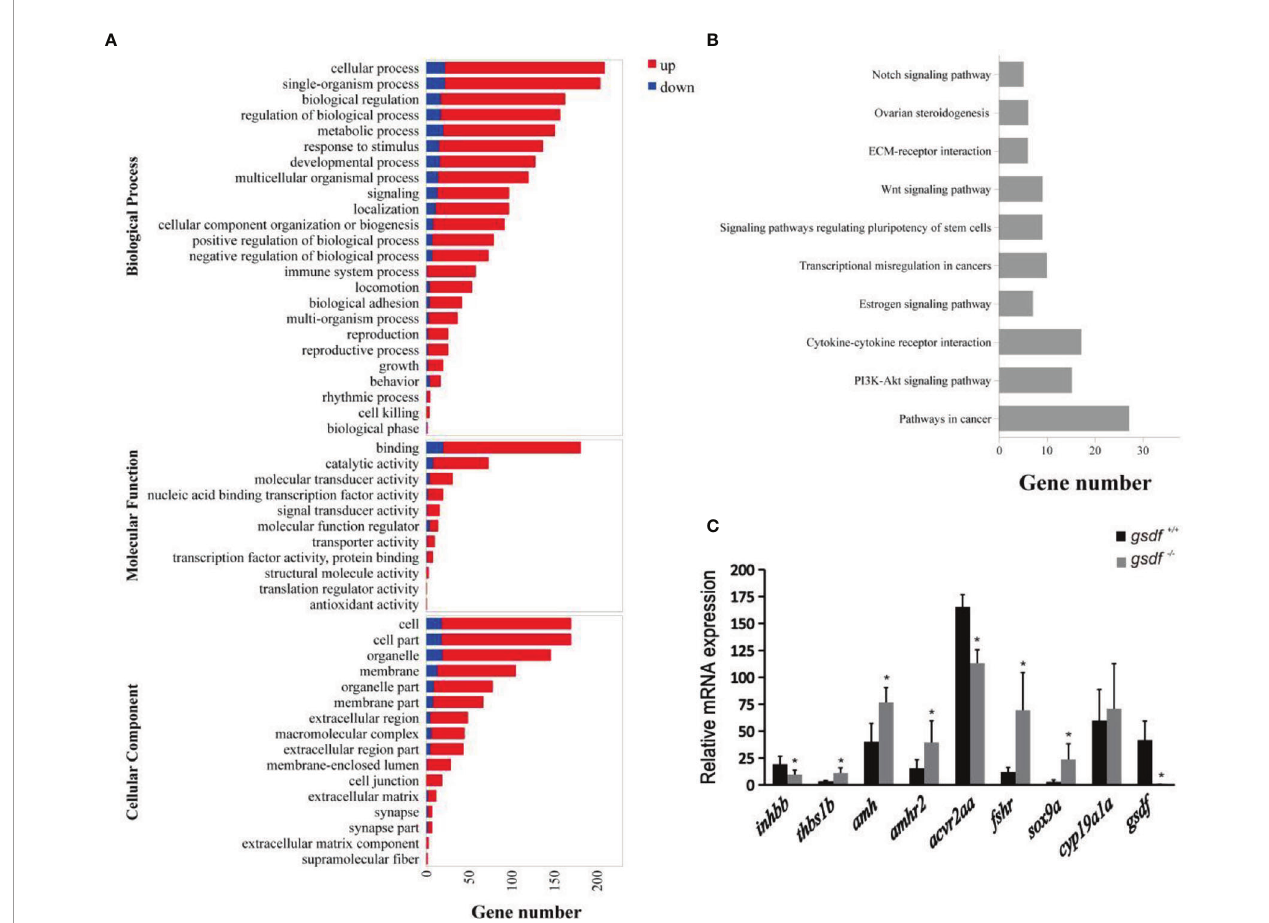
FIGURE 2 | Transcriptome analysis of gene expression in ovaries of XX gsdf -/- and gsdf +/+ tilapia at 6 mah. (A) GO enrichment analysis of DEGs. Red and blue indicate up-regulated and down-regulated DEGs, respectively. (B) The top ten enriched KEGG pathways of the DEGs. (C) qPCR validation of the transcriptome data. All the examined genes showed similar expression patterns with the transcriptome data. Results are presented as mean ± SD. * indicates signi fi cant difference at P <